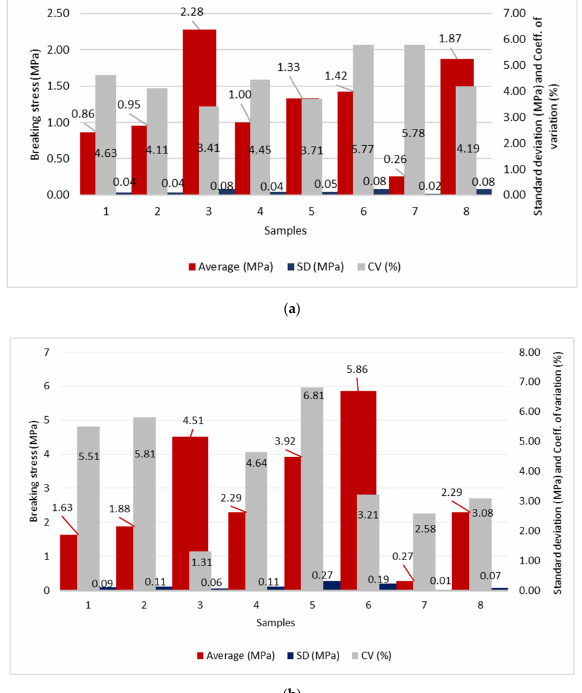
Figure 1. Breaking stress; ( a ) in longitudinal direction and ( b ) in transverse direction; Average breaking stress in MPa; SD—standard deviation in MPa; CV—coefficient of variation in %.